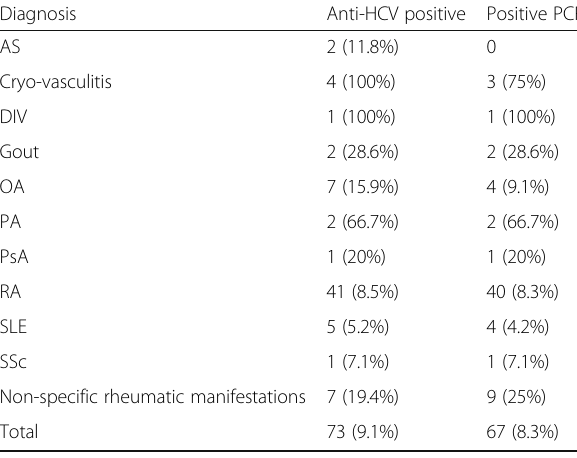
Table 4 Distribution of the anti-HCV-positive and PCR-positive patients among different diseases